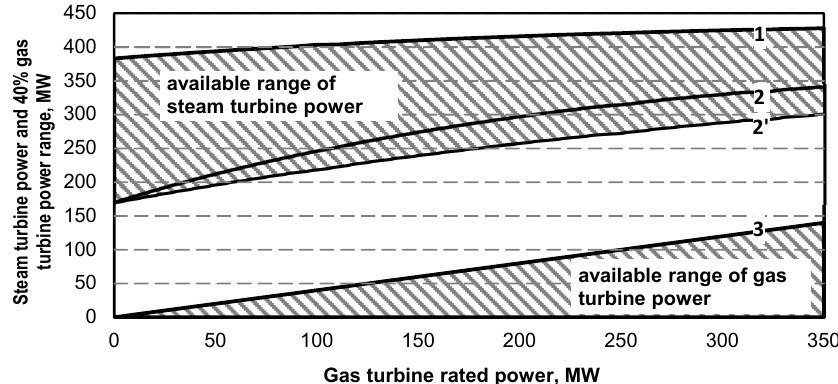
Figure 27. Steam turbine power as a function of gas turbine rated power: 1 — fixed stream of 319.4 kg/s fresh steam fed to steam turbine; 2 – minimum steam boiler output of 133.3 kg/s and gas turbine operating at a rated power, 2’ — minimum steam boiler output of 133.3 kg/s and gas turbine operating with 60% of its rated power, 3 — 40% of gas turbine rated power.